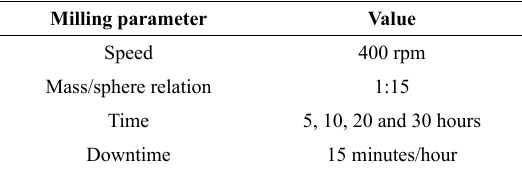
Table 1. Parameters used in the AISI 52100 steel milling